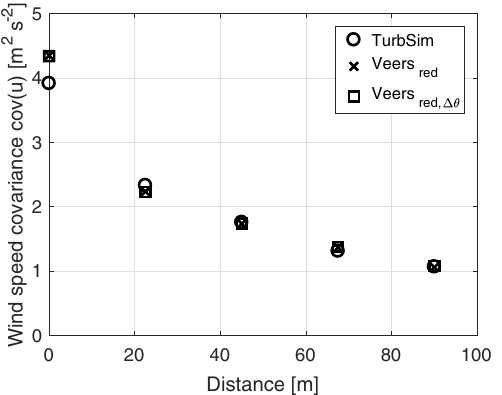
Figure 8. Wind speed covariance for points different distances